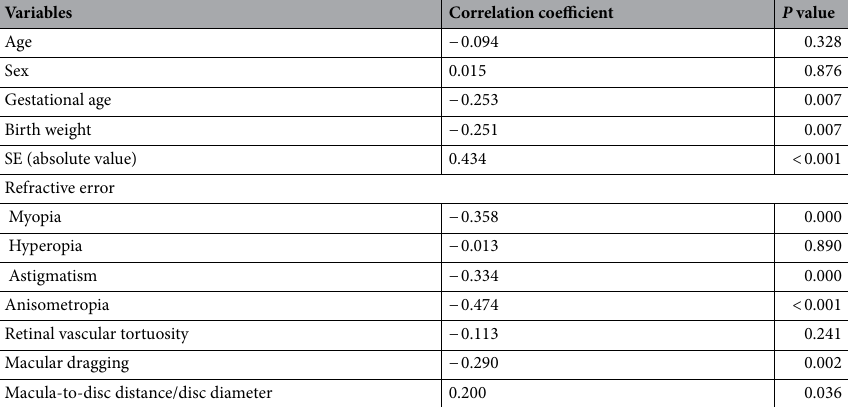
Table 2. Spearman’s correlation analysis of best-corrected visual acuity (BCVA) and clinical variables. Values are presented as numbers (%) or mean ± standard deviation (range). Myopia, spherical equivalent (SE) ≤ −